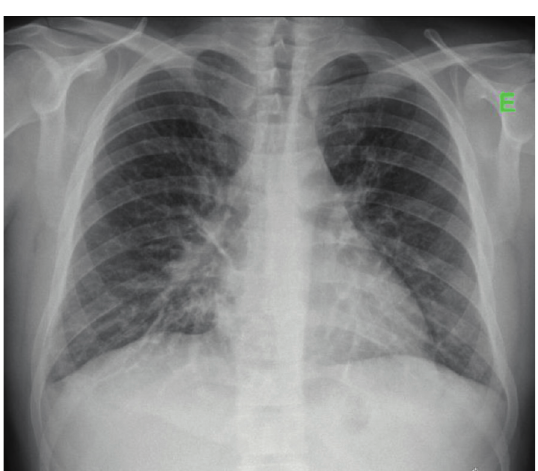
Figure 1: Chest X-ray performed on the 2 nd trip to the ER: bilateral perihilar reinforcement, erasure of both costophrenic sinuses, and diffuse interstitial infiltrate are observed.